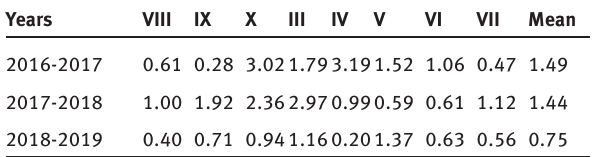
the same number of productive branches, in the second year of research, a similar tendency was observed in the population morphotype and the long-stem hybrid, while in the last growing season in all tested varieties. This research did not show the interaction of years with varie- ties in relation to the number of pods per plant, length of pods and the number of seeds in pods.